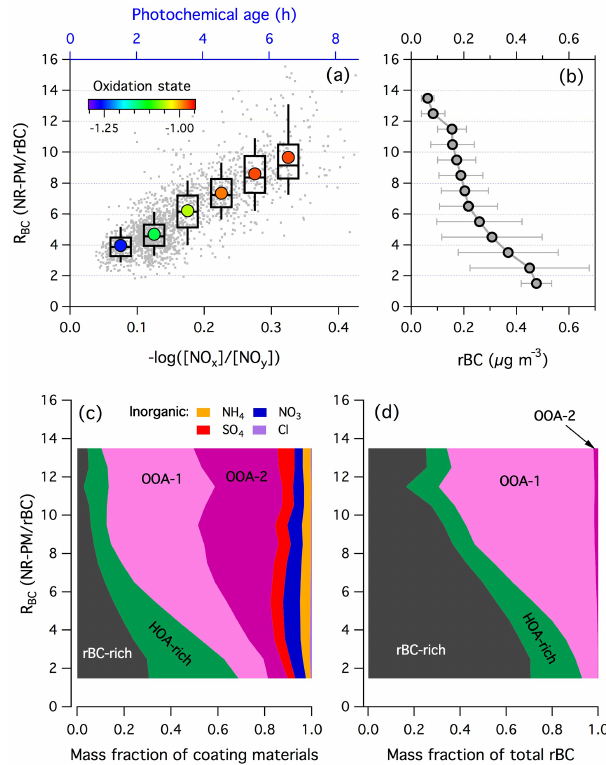
Figure 4. Coating thickness ( R BC ) as a function of (a) photochem- ical age, (b) rBC mass loadings, (c) chemical compositions of coat- ing, and (d) rBC mass fractions contributed by individual PMF fac- tors within the hot